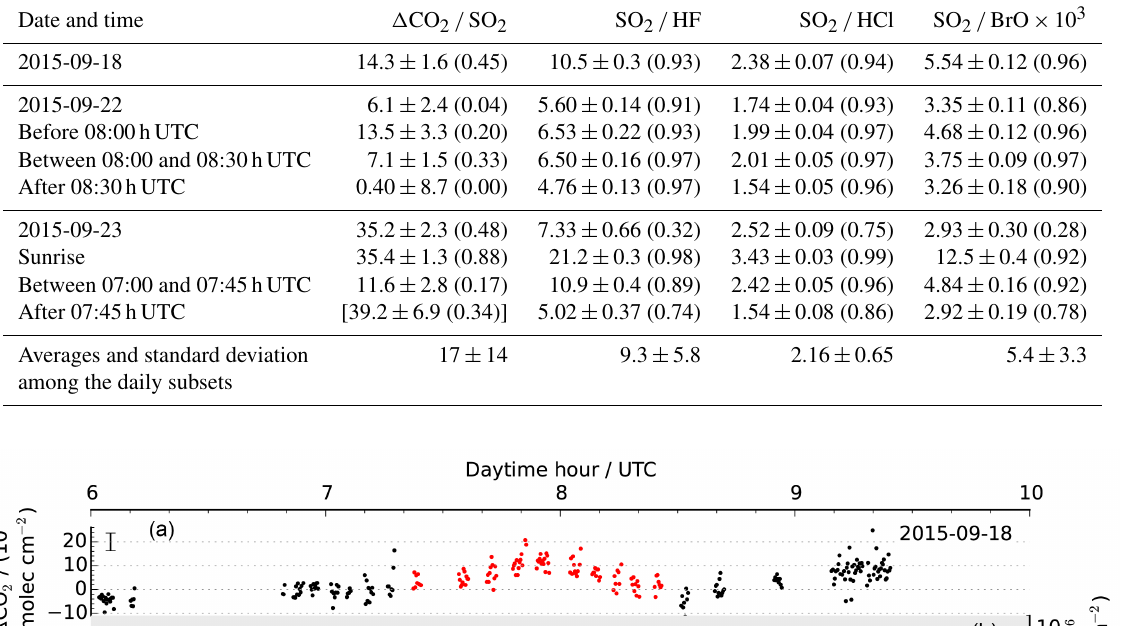
Table 3. Intra-plume VCD ratios found by fitting a straight line to the correlations shown in Figs. 10 through 13. The errors are the standard deviations of the fitted slopes. The R 2 of the linear fit is shown in parentheses. On 22 and 23 September, we inferred VCD ratios for the whole day and three subsets separately. The lowermost row provides the campaign-averaged VCD ratios and standard deviations calculated from the daily subsets. The (cid:49) CO 2 / SO 2 ratios for the measurements after 07:45UTC (bracketed) on 23 September need to be considered with care since (cid:49) CO 2 is negative. For details see text.